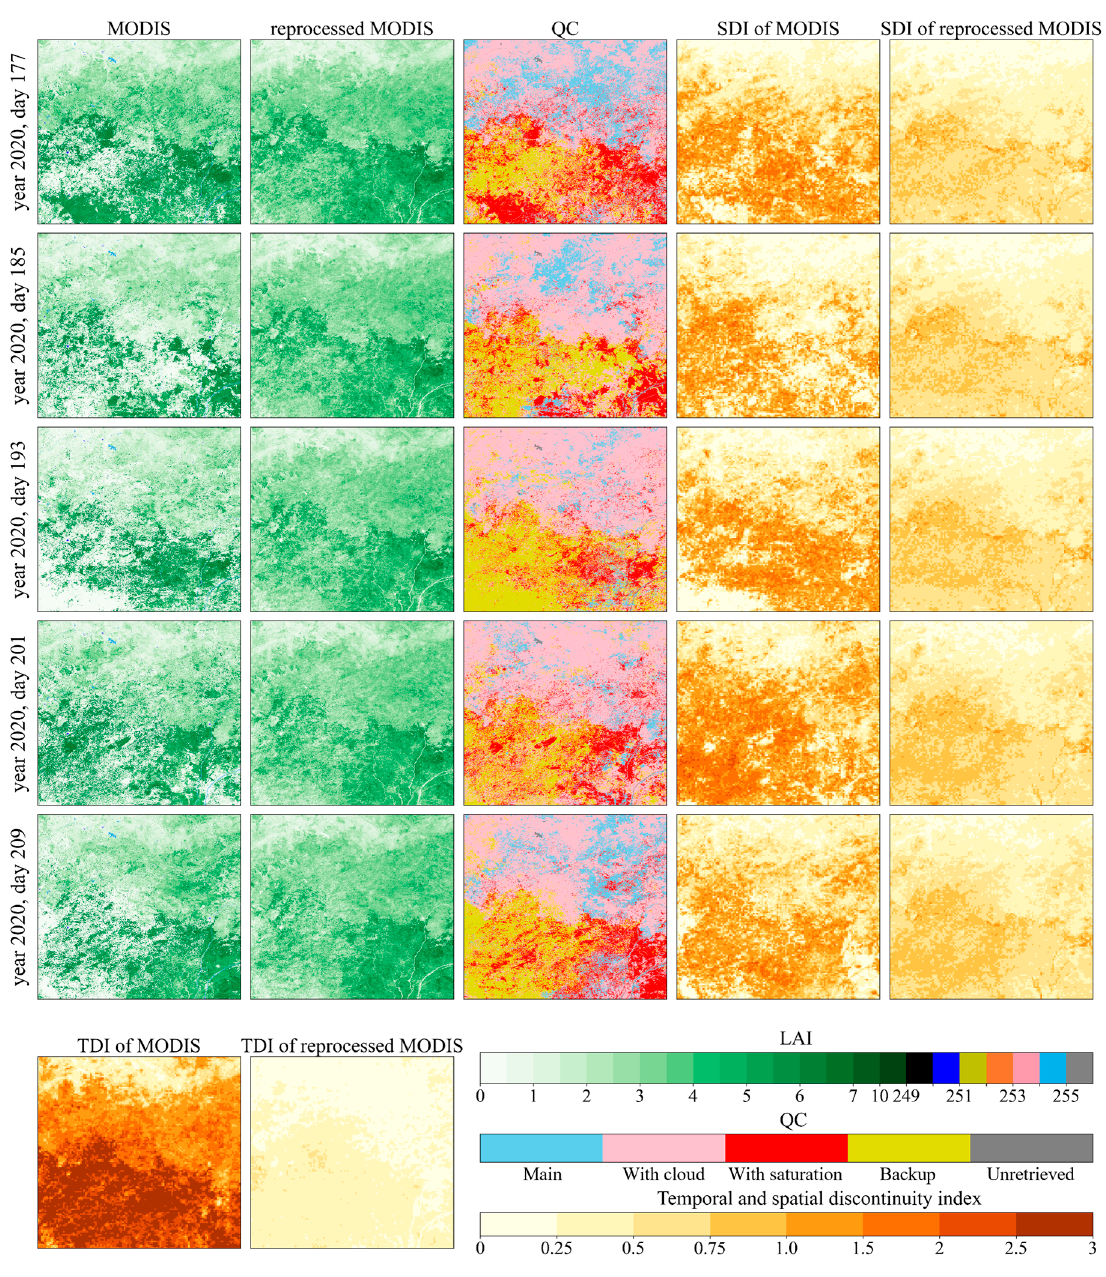
Figure 4. Spatial and temporal comparisons between MCD15A2H C6.1 and reprocessed MODIS LAI in tile h19v08. The location of the center of this tile (1200 × 1200 km 2 ) is 15.055 ◦ E, 5.002 ◦ N. The first column’s first five subplots show the MODIS LAI for the five 8-day compositing periods that are labeled to the figure’s left. The second column’s first five frames refer to reprocessed MODIS LAI. Information on quality control is divided into five categories, as listed in Table 1, and displayed in the “QC” column. The last two columns display, respectively, the spatial discontinuity index (SDI) of MODIS and reprocessed MODIS. The last row displays the temporal discontinuity index (TDI) of MODIS and reprocessed MODIS of the above five 8-day compositing